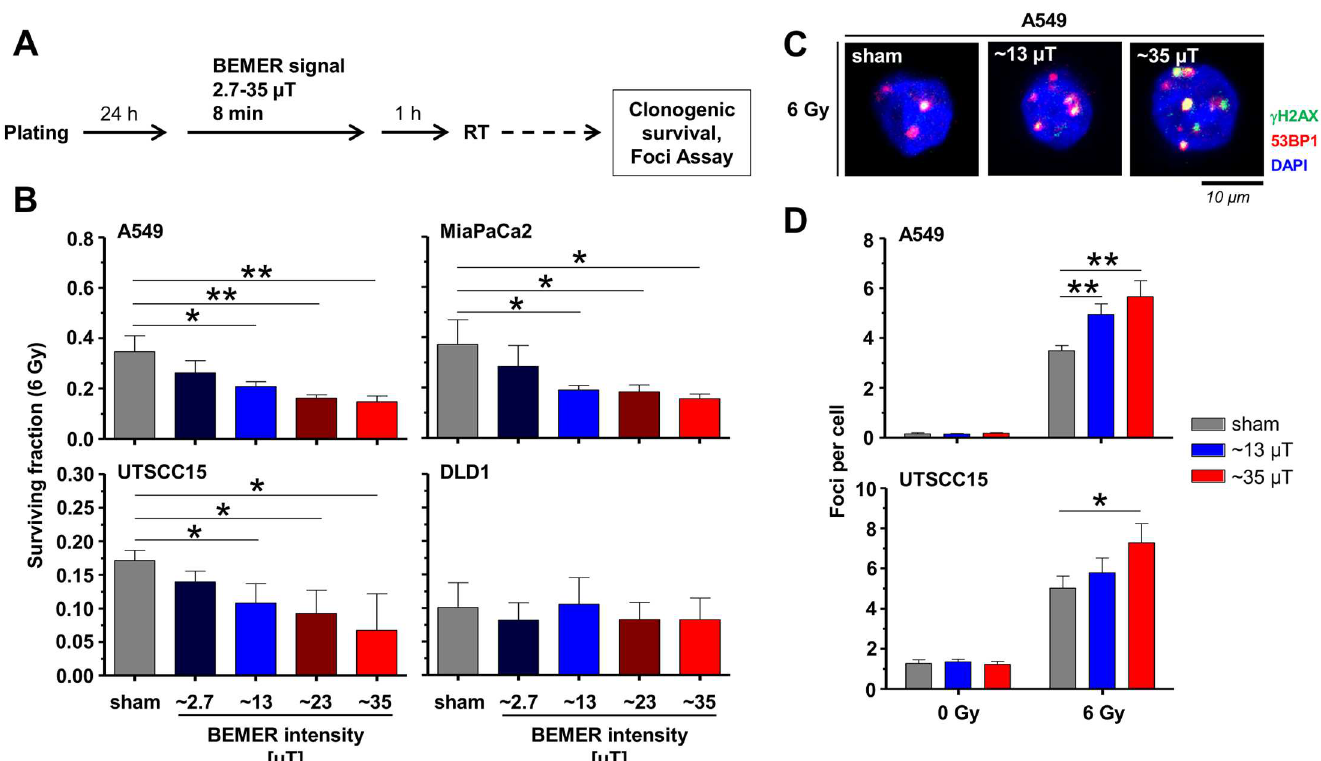
Fig 8. BEMER signal intensity determines radiosensitization and DSB numbers. (A) Flow chart of colony formation assay and foci assay. (B) Clonogenic survival after 6-Gy irradiationcombinedwith BEMER therapy (2.7–35 μ T; 8 min) of A549 and UTSCC15cells. (C) Immunofluorescence images show nucleiwith γ H2AX/53BP1-positive foci after 6-Gy irradiationwith (~13 or ~35 μ T; 8 min) and without BEMER therapy in A549 cells. (D) Number of γ H2AX/53BP1-positive DSBs 24 h after irradiationin A549 and UTSCC15cells. BEMER sham-treated (sham), irradiatedcells served as control. All results represent mean ± SD. Student’s t-test. n = 3. * P < 0.05; ** P < 0.01.